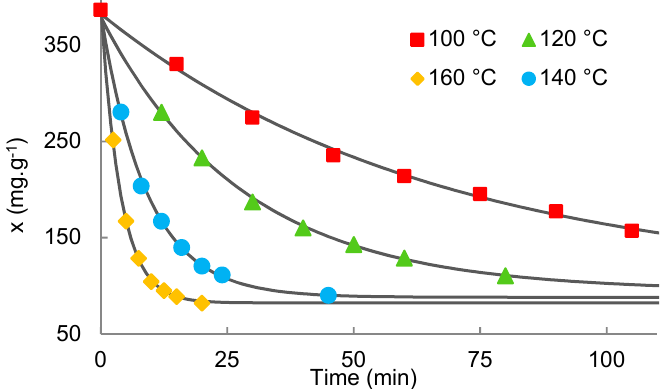
Figure 8. Time dependence of the ethanol concentration during the transesterification of oligomeric lactic acid with ethanol (marks—experimental data; curves—model according to Equation (15)).